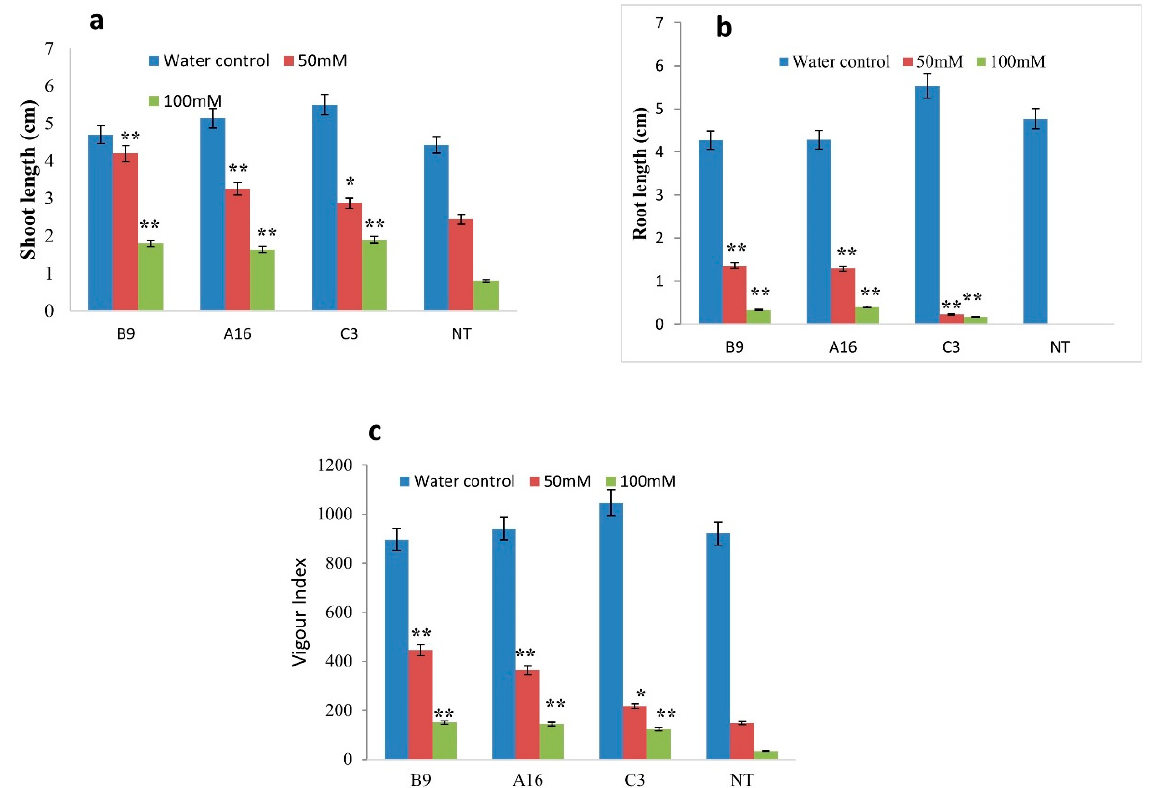
Figure 6. Shoot length; ( a ) root length; ( b ) and Vigor Index; ( c ) measured in non-transgenic (NT) and transgenic ADT 43 (T 1 ) seedlings germinated at different levels of NaCl concentration. Each value is a mean of fifteen replications. ** indicates statistical significance at p < 0.01 and * indicates significance at p < 0.05 (ANOVA compared to non-transgenic salinity stressed) .